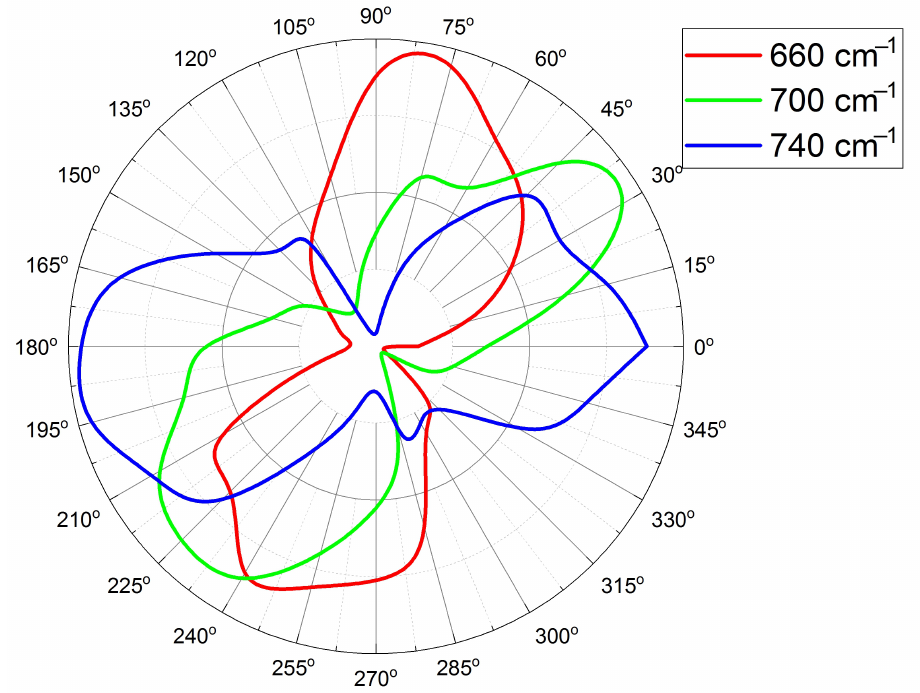
Figure 7. Effective polarization calculated for each given wavenumber (660, 700, and 740 cm − 1 ), as: ( T ( φ ) / T ( φ − 90 ◦ ) − min [ T ( φ ) / T ( φ − 90 ◦ )]) / ( max [ T ( φ ) / T ( φ − 90 ◦ )] − min [ T ( φ ) / T ( φ − 90 ◦ )])